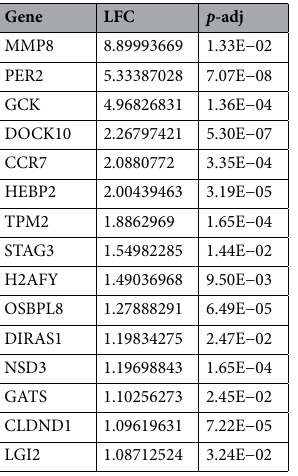
Table 1. Top 15 over-expressed genes in osteoclasts on cartilage. LFC Log fold change; padj p value